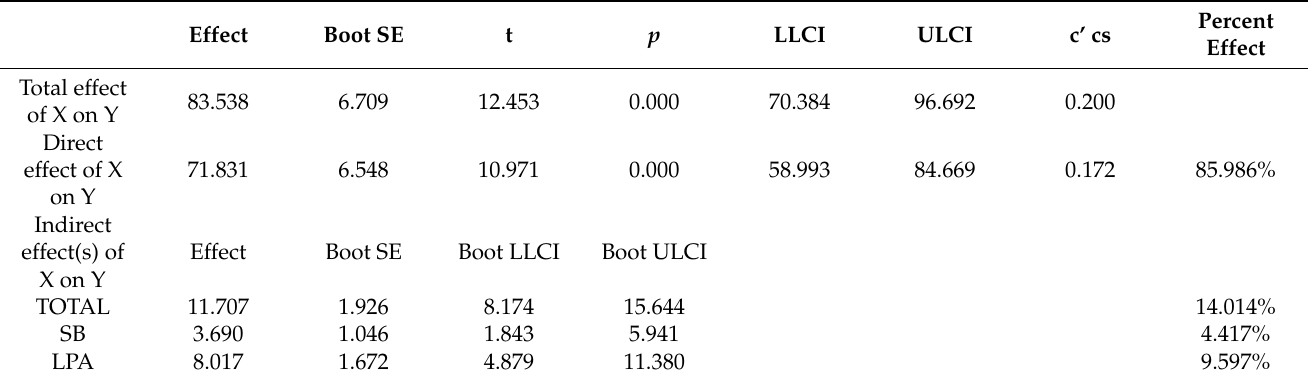
Table 6. Parallel mediation effect